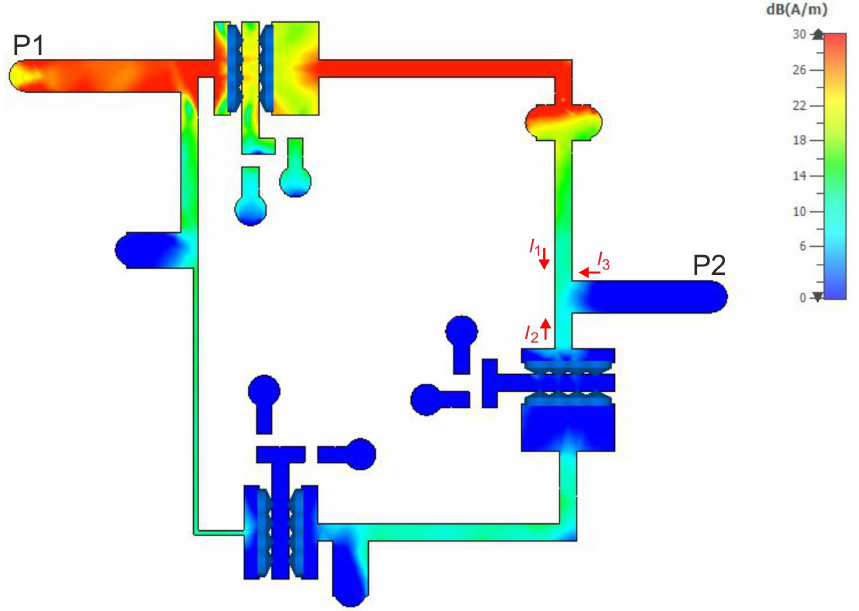
Figure 19. Current density distribution at the upper TZ frequency (700 MHz).